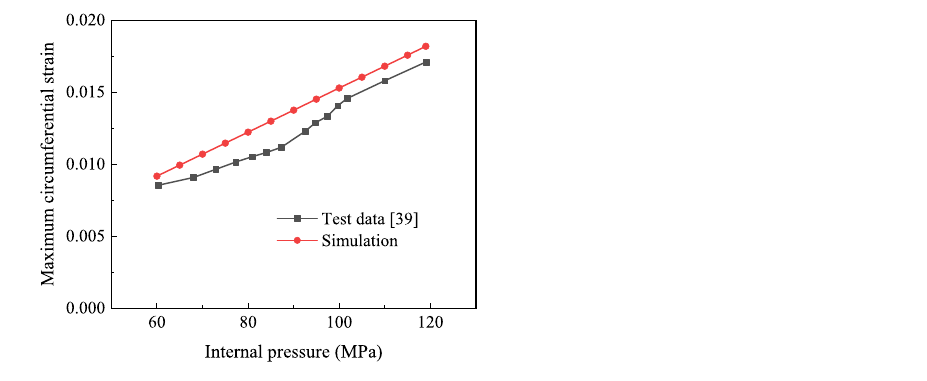
Figure 23. Comparison of circumferential strain between simulation and reference curve.